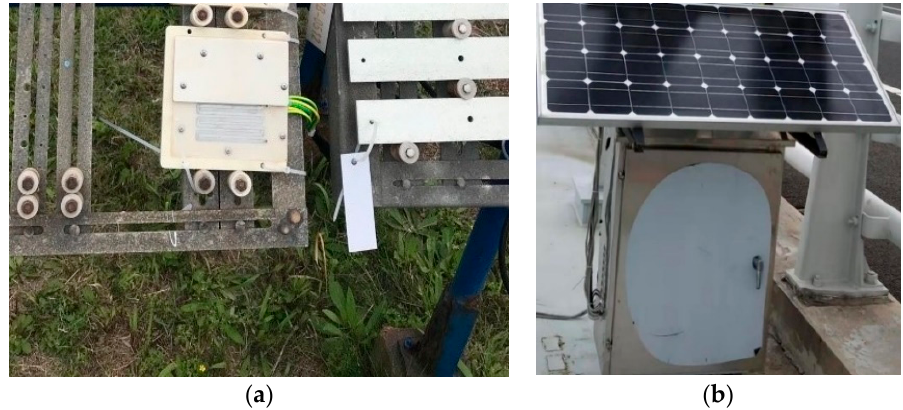
Figure 4. The field test details. ( a ) Electrical resistance sensor before experiment; ( b ) Appearance of IoT ACM.